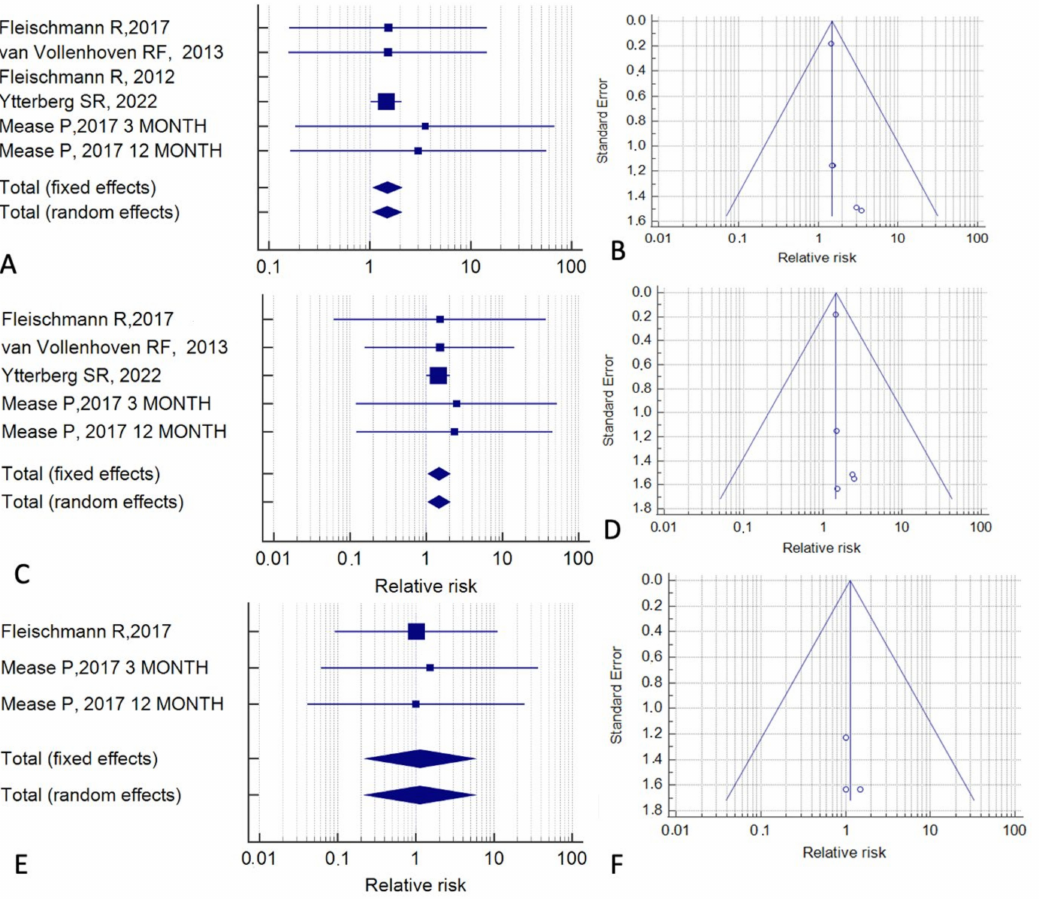
Figure 7. Cancer risk associated with tofacitinib treatment relative to treatment with anti-TNF agents. ( A , B ) All cancers. ( C , D ) All cancers except non-melanoma skin cancer. ( E , F ) Non-melanoma skin cancer. ( A , C , E ) Forest plots of relative risk. ( B , D , F ) Funnel plots for the assessment of publication bias